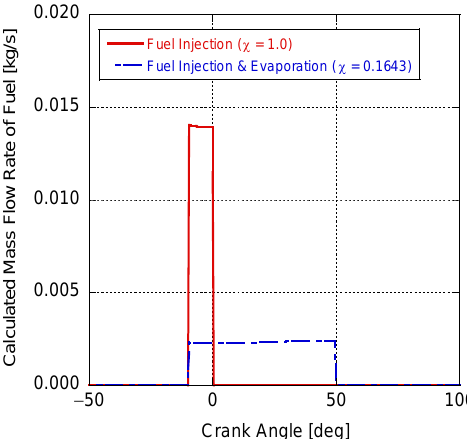
Figure 3. Calculated mass flow rate of fuel injection as is and including a factor that simply estimates the evaporation process.